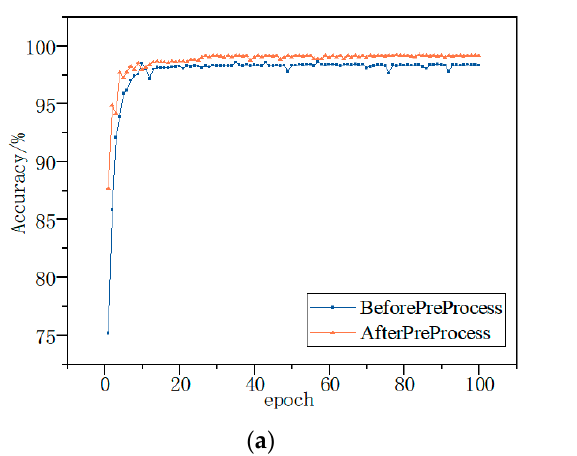
( b ) Figure 12. DataCon dataset accuracy and loss; they should be listed as: ( a ) Description of accuracy; ( b ) Description of loss. It can be seen that by using the features following the Spearman’s correlation coeffi- cient selection, the proposed model is able to accurately classify and detect malware on both datasets, with a significant improvement in accuracy and convergence speed relative to the pre-feature selection. The results show that the use of feature selection can largely mitigate the impact of unbalanced malware family samples, thus improving the final de- tection accuracy. 4.3.2. Noise Analysis Experiments In this section, the impact of noise on the model accuracy is verified through the noise robustness experiments of SFCWGAN- and BiTCN-based malware detection methods. Different levels of Gaussian white noise were added to the Kaggle and DataCon datasets, obeying 0.01, 0.03, and 0.05. Table 4 shows the results.